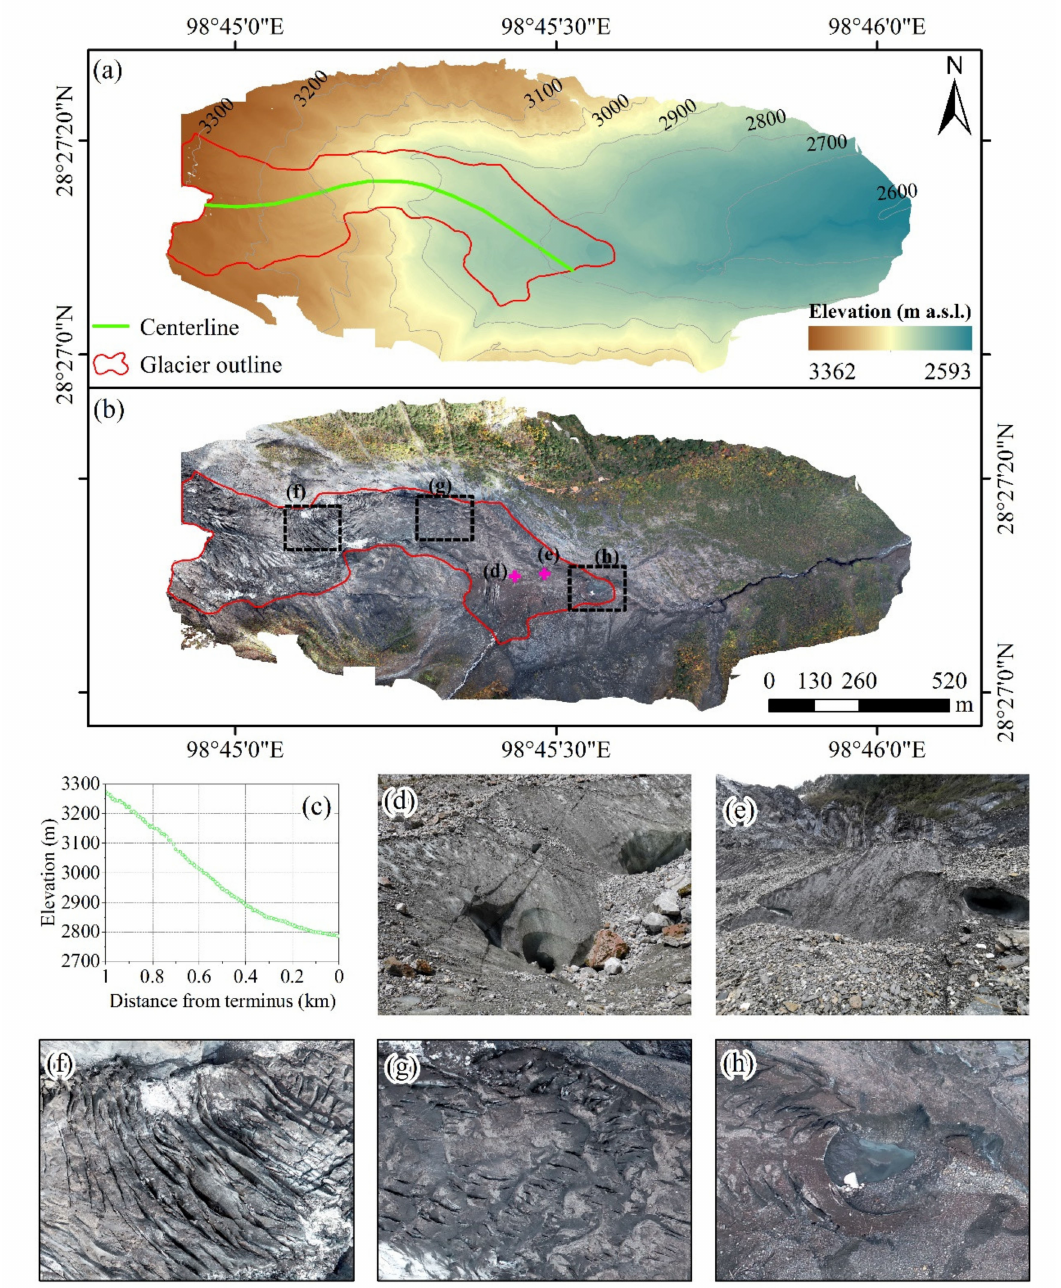
Figure 5. ( a , b ) The DSM and orthophoto in November 2019. ( c ) The surface elevation along the centerline. ( d , e ) Ice cliffs in glacier terminus. ( f ) Transversal crevasses. ( g ) Longitudinal crevasses. ( h ) Proglacial lake in glacier